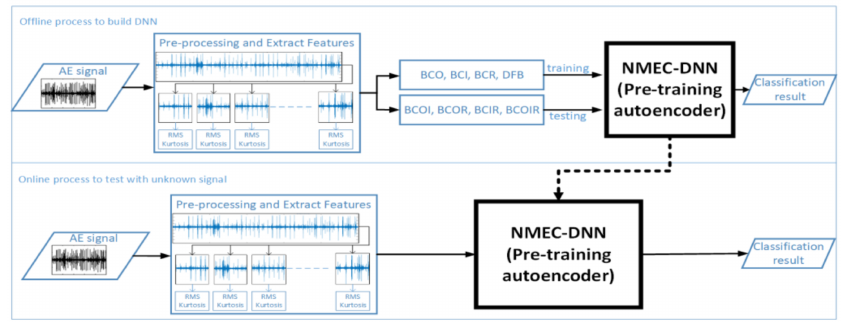
Figure 3. The process of classification by non-mutually exclusive classifier-deep neural network (NMEC-DNN).